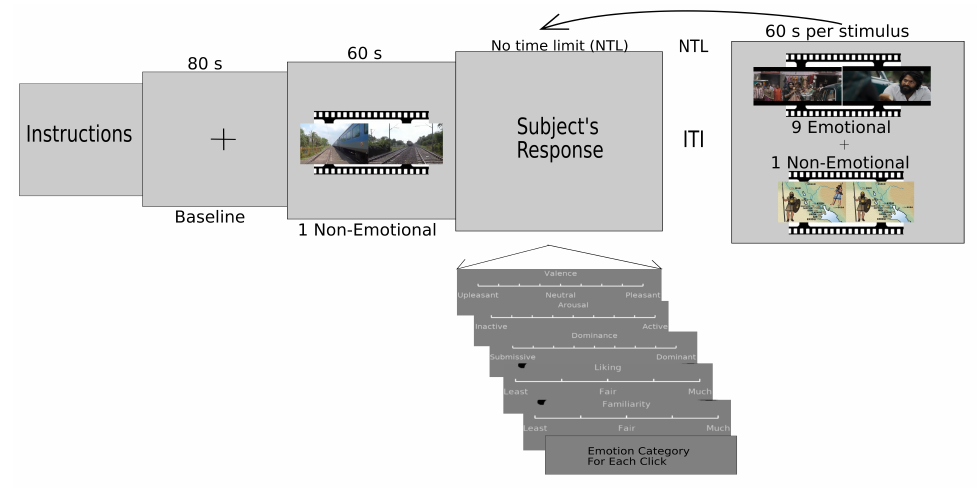
Figure 1. Experiment Paradigm: Each participant was shown 11 60-s long video stimuli. One non- emotional stimulus was shown after the baseline recording. Nine emotional stimuli were presented with order randomized. Another non-emotional stimuli was shown after the fifth and before the eighth video. There was no time limit during the ratings and inter-trial interval. Participants could resume watching the next stimulus after clicking the left button on the